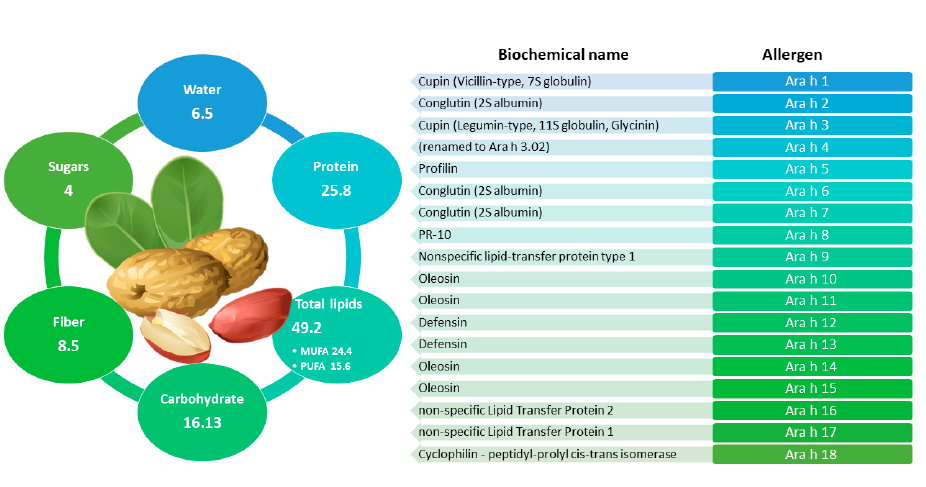
Figure 7. ( Left ) relevant information on the nutritional composition (g/100 g) relating to the Arachis hypogaea L. species. ( Right ) list of allergenic proteins identified and registered to date on the WHO/IUIS online allergen platform.